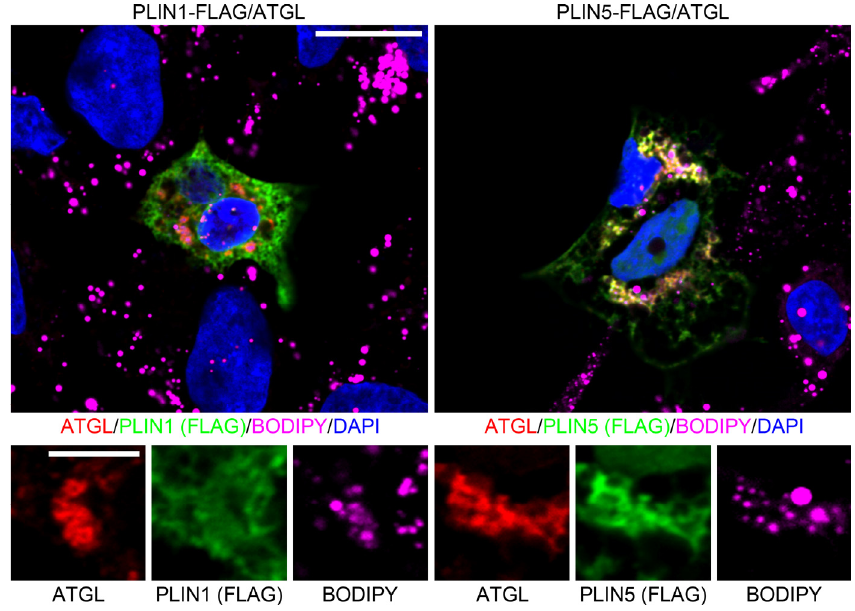
Figure A5. Perilipin 1 does not displace ATGL from lipid droplets (LDs). Immunofluorescence microscopy of perilipin 1 (PLIN1, green, left) or perilipin 5 (PLIN5, green, right) with ATGL (red) in transfected HepG2 cells (LD: BODIPY, violet, nuclei: DAPI, blue). HepG2 cells were transfected